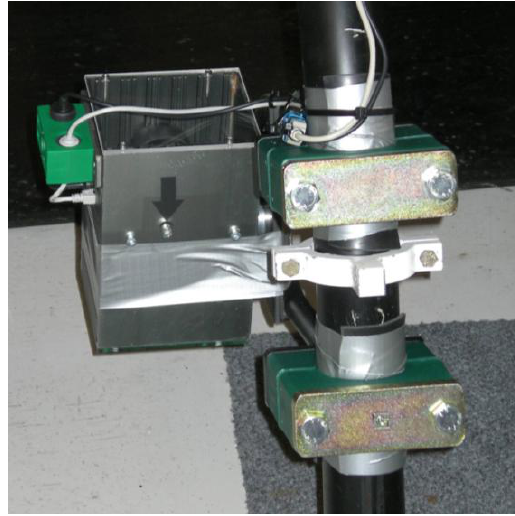
Figure 1. The camera system attached to the helicopter support landing gear. The arrow points to the hole, through which the camera was mechanically